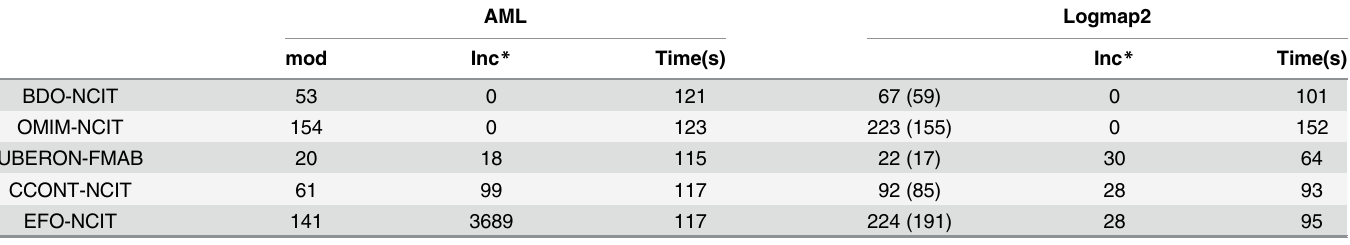
Table 8. Evaluation of the repairs produced for the five Bioportal alignments. Mod denotes the total number of modifications to the alignment (with removed mappings shown in parentheses when systems also alter mapping relations) and Inc denotes the number of incoherent classes. AML